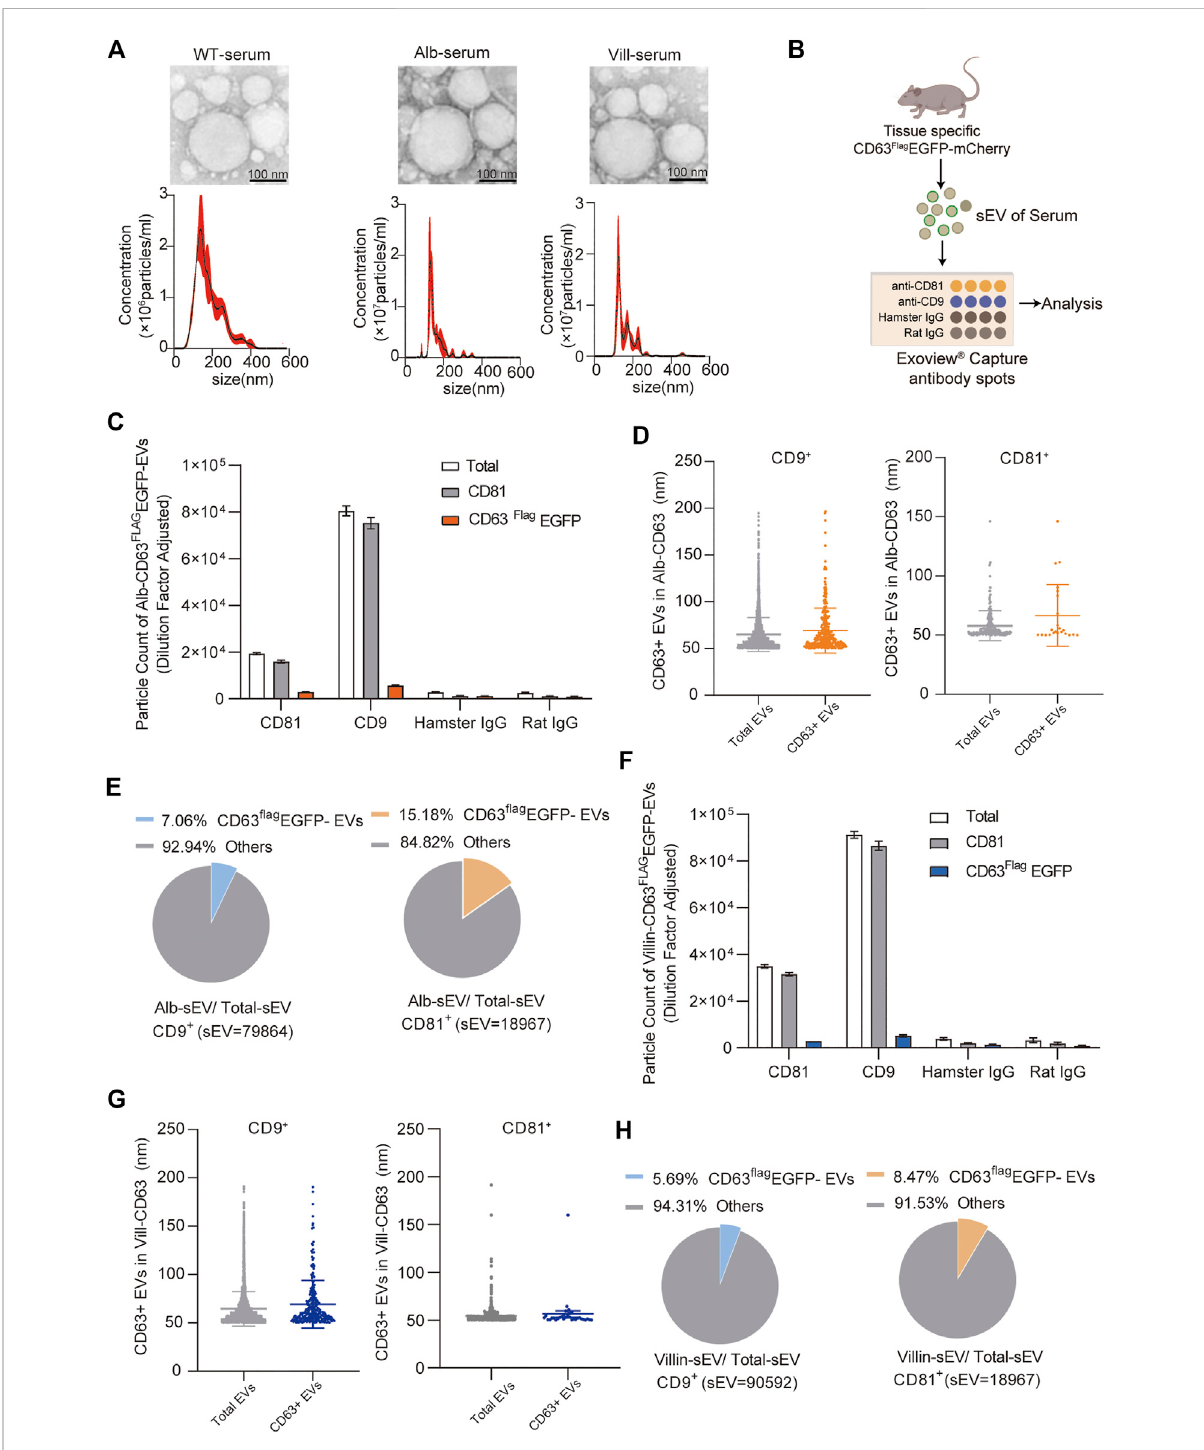
FIGURE 5 Characterization and quanti fi cation of tissue-speci fi c CD63 Flag EGFP-mCherry serum EV (A) Nanoparticle tracking analysis (NTA) and transmission electron microscopy (TEM) of EVs isolated from mouse serum (WT, wild-type; Alb, Alb-CD63 Flag EGFP-mCherry; vill, villin- CD63 Flag EGFP-mCherry). ( n = 4) (B) Schematic representation of ExoView microarray analysis of the serum of tissue speci fi c-CD63 Flag EGFP- mCherry. ( n = 3, collected serum sEV mixed to one sample for Exoview detection) (C) Particle counts of serum sEVs captured by CD81 and CD9 antibodies respectively using ExoView technology from Alb-CD63 Flag EGFP-mCherry mouse. (D) The size of CD63 Flag -EGFP + sEVs captured by CD9 antibody (left)and CD81 antibody (right)using Exoview technology from Alb-CD63 Flag EGFP-mCherry mouse serum. (E) Pie charts